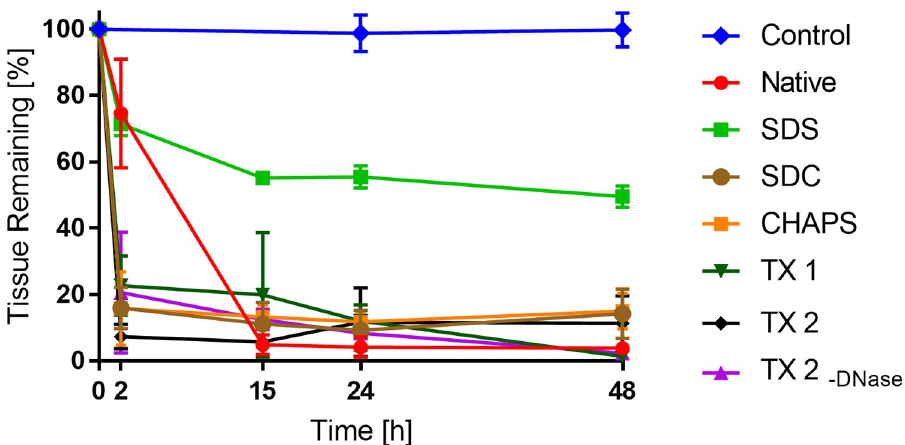
Fig 4. Assessment of tissue biodegradability. Biodegradability was measured by incubating lyophilized samples from decellularized or native porcine vena cava (n = 4 in each group) with 0.1% Collagenase I or PBS (negative control) and the tissue weight was measured at 0, 2, 15, 24 and 48h. The diagram shows the percentage of remaining tissue weight compared with time